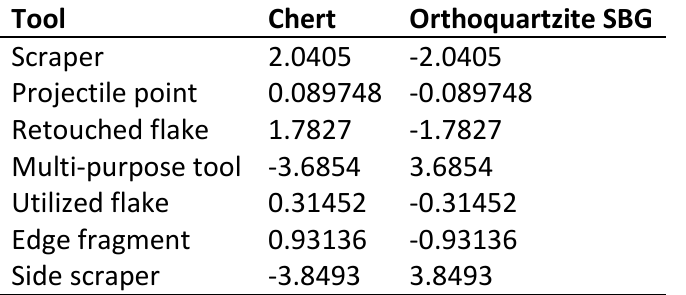
Table 4. Results obtained through the chi-square goodness of fit test. Rows, columns=7, 2. Degrees freedom=6. Chi 2 =32.747. Monte Carlo